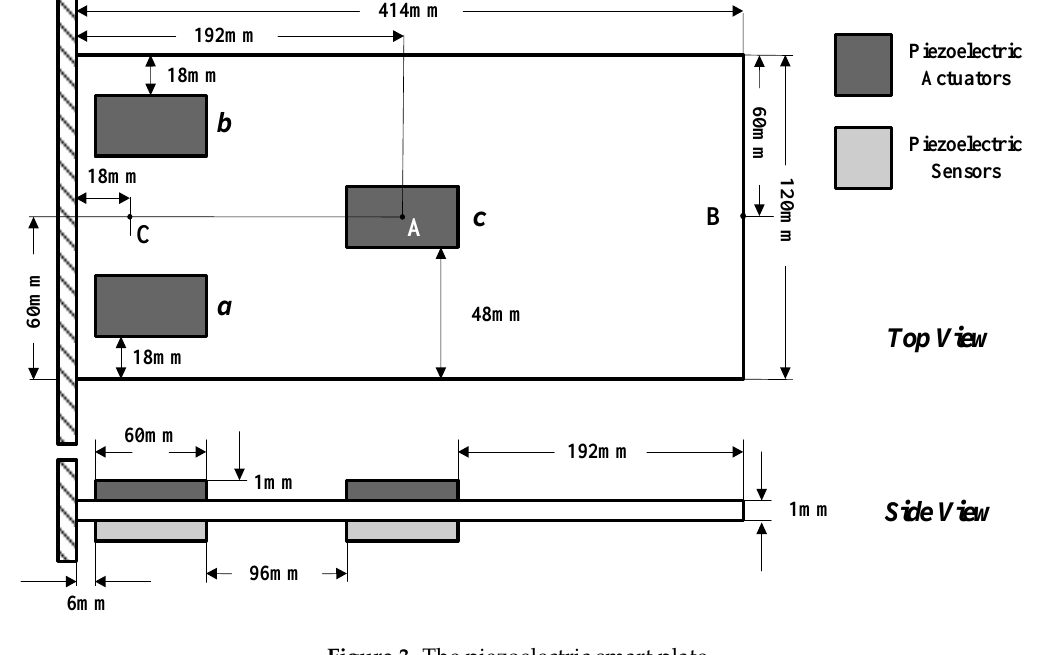
Figure 3. The piezoelectric smart plate. Table 3. Properties of the GE composite material and the piezoelectric